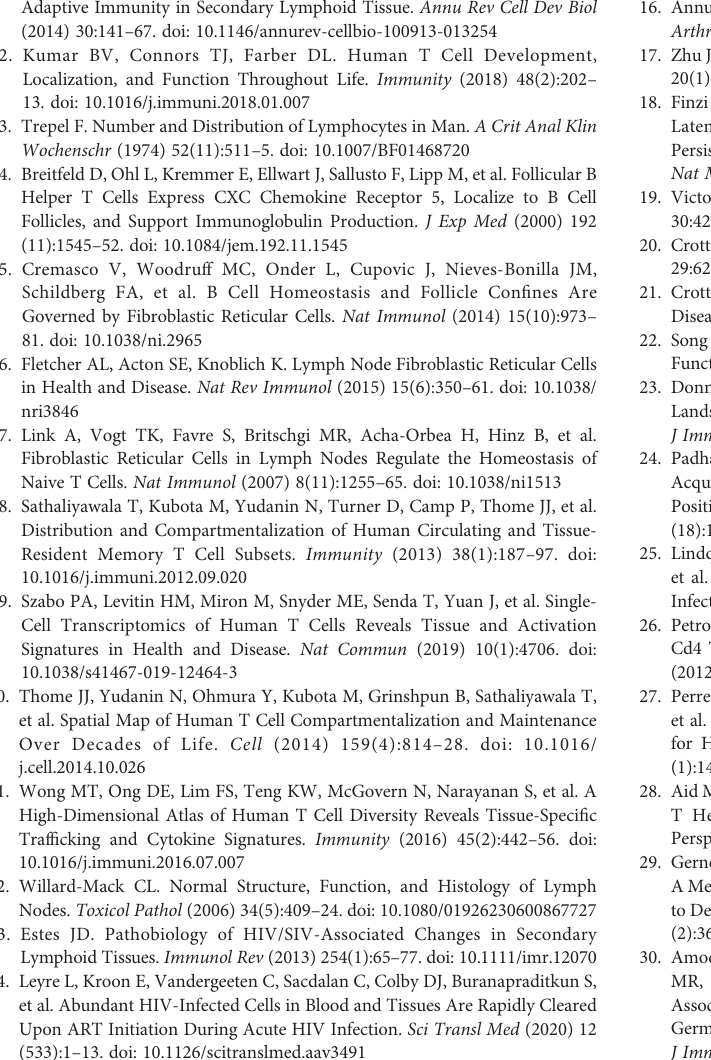
after application of the alternative CD8 T cell imaging panel. Images were acquired at 40x (NA 1.3) with 1% zoom. Scale bars are 100um, 50um and 10um. Supplementary Figure 3 | CD8+ FasL +/- GrzB +/- T cells in tonsils and LNs, IF-FISH RNAscope staining controls and fl uorescence minus one (FMO) controls. (A) Histocytometry plots showing the distribution of imaged follicles in one tonsillar and one HIV+ LN tissue as denoted by CD20 (cyan) and Ki67 (magenta) staining and the gating strategy used for the identi fi cation of CD8+ FasL GrzB expressing populations within these localities. Red circles denote individual follicles. The cumulative frequencies of CD8+ Fas L+/- GrzB +/- T cells for all follicles measured in the two types of samples are shown in the bar graph. Each type of sample is denoted by a different colour. (B) Confocal microscopy images showing two sequential LN tissue sections from an HIV+ individual stained with an HIV+ vRNA+ speci fi c probe and antibodies speci fi c for the protein markers CD3 (cyan) CD4 (magenta) and FDC (green) in the absence (section 1) or presence (section 2) of an RNase A/T1 pretreatment step. The localization of the vRNA+ signal (red) on the FDC network (green) is shown. (C) Representative example of FMO controls used